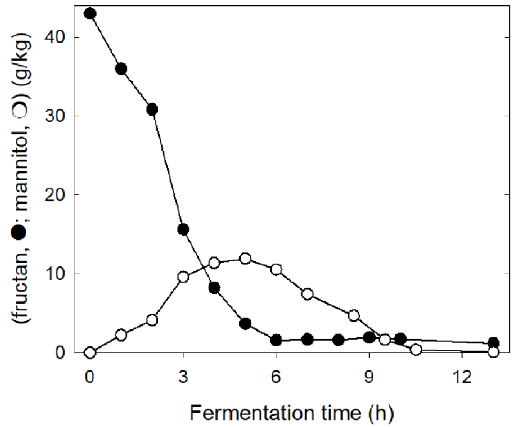
Figure 3. Degradation of fructans (black) and the formation and degradation of mannitol (white) in a type II rye sourdough. Sourdough microbiota consist of fructan-degrading strains of the L. delbrueckii group and heterofermentative strains of the L. reuteri group, which convert fructose to mannitol. Drawn with data from [65].